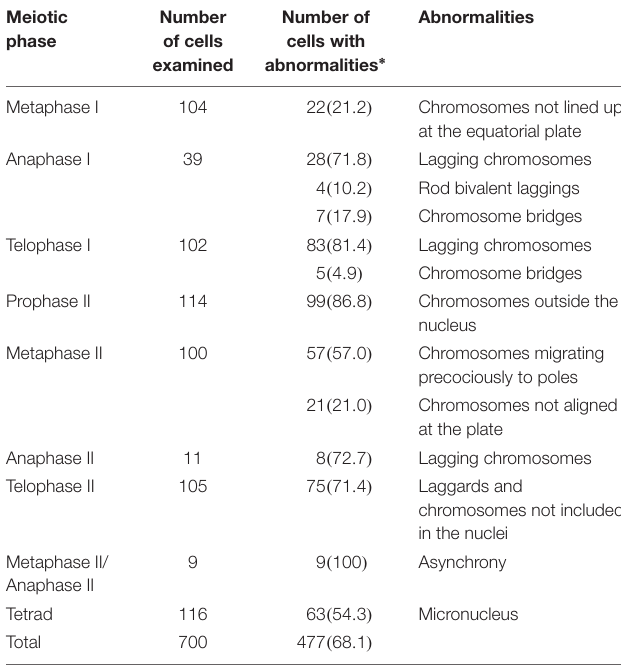
FIGURE 2 | (A) Distribution of chromosome counts in 20 mitotic cells of IACSP93-3046, previously treated with 8-hydroxyquinoline. (B) A metaphase cell showing 2n = 112 chromosomes; the arrow points to a satellite chromosome. Bar, 10 µ m.